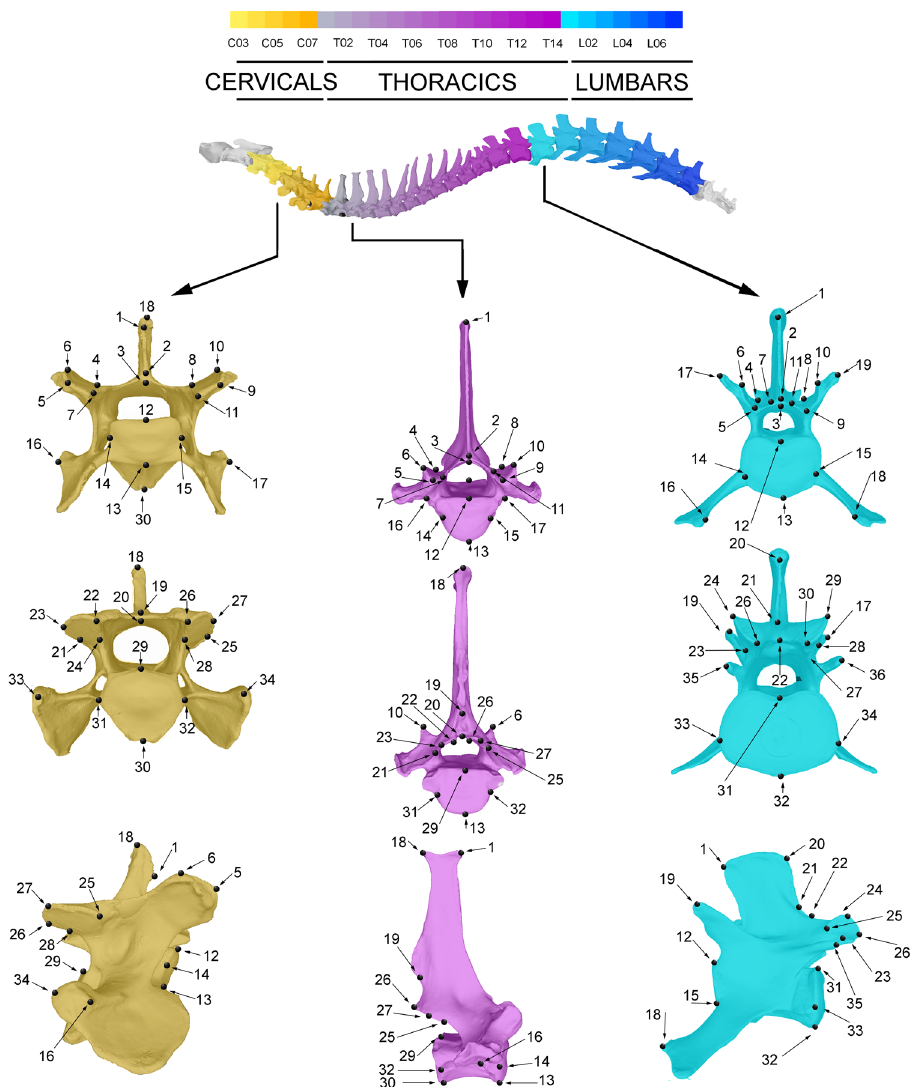
Fig. 9 Landmarks digitized in this study, taking the 3D models of a third cervical, fi rst thoracic and fi fth lumbar vertebra of a grey wolf ( C. lupus ) as an example. For information on the anatomical criteria followed to digitise de landmarks see Supplementary Table (2) Disparity through time analyses : For each vertebra, we calculated the proportional disparities of carnivoran subclades in relation to total carnivoran disparity, and how this varied through time (i.e. for subclades of different ages) using the “ disparity through time ” method of Harmon et al. 47 applied to allometry- corrected vertebral shape data (i.e. the residuals of a phylogenetic Procrustes ANOVA of shape on size 48 ) for both sampling approaches — i.e. grouping by number and with a set of selected vertebrae by position. This is implemented in the dtt function of the R package geiger 48 . This describes the timing of evolutionary morphospace partitioning among subclades and is compared to an expectation line computed by simulating continuous multivariate trait evolution under Brownian motion 49 . High relative subclade disparities indicate that subclades have highly overlapping morphospaces and high disparity, expressed as a share of the whole- clade disparity. This suggests constrained morphological evolution in which subclades repeatedly explore the same regions of morphospace. Low relative subclade disparities indicate strong partitioning of morphospace into clade-speci fi c subspaces that each occupies a small proportion of the whole-clade disparity. This variation is summarised using the MDI, which describes the difference between the observed DTT trajectory and the expected DTT trajectory according to a BM model, using the R package geiger version 2.0.6.1 49,50 . Positive MDI values indicate substantial morphological overlap between subclades, whereas negative MDI values indicate that subclades have individually low disparities compared to the total clade, suggesting partitioning of morphospace among subclades 51 . (3) Correlations of vertebral shape vs locomotor capabilities : To test the association between vertebral shape and the ecological capabilities of species, we used a phylogenetic Procrustes ANOVA for each vertebra using the procD.pgls